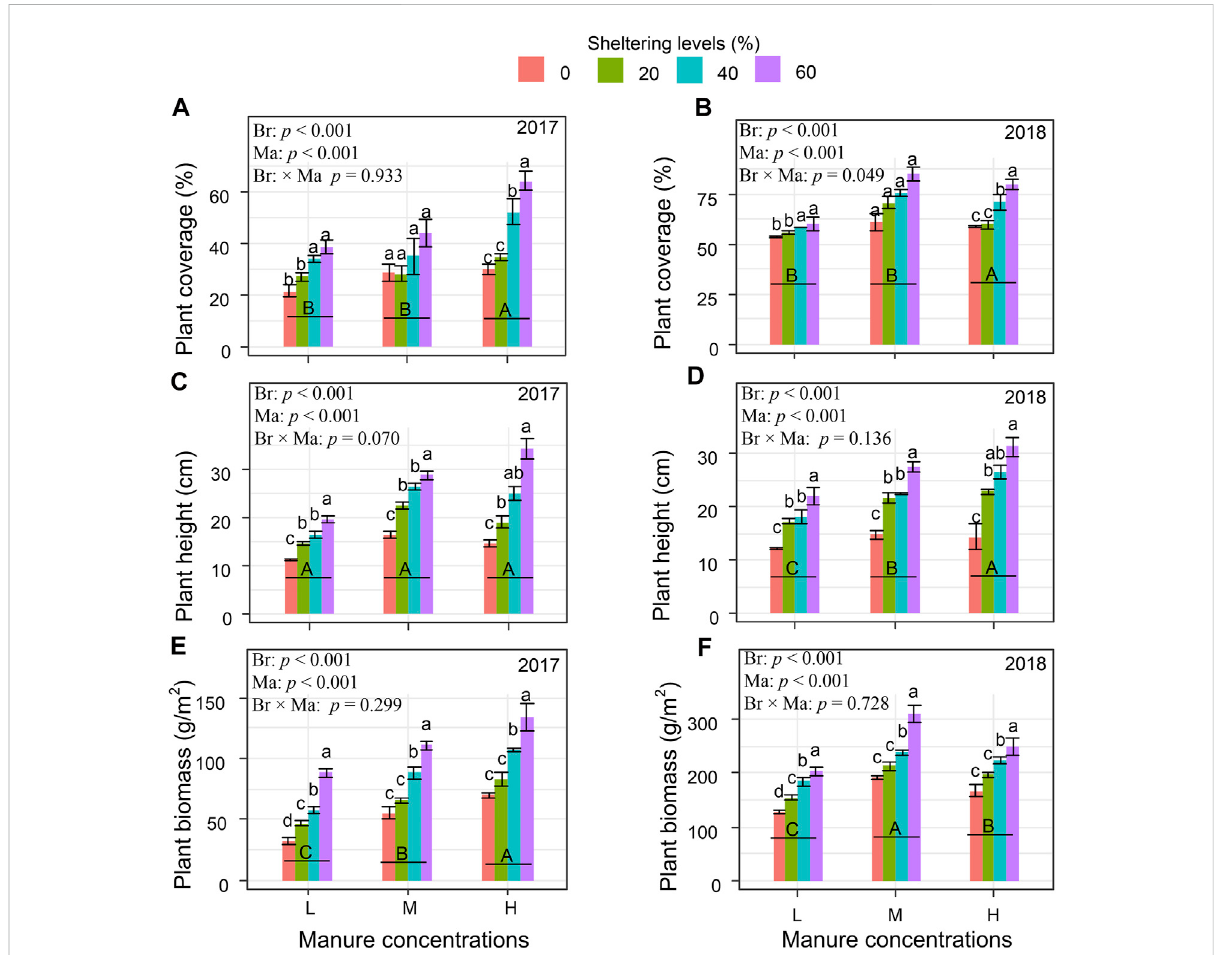
FIGURE 5 Plant coverage (A,B) , height (C,D) , and biomass (E,F) under different shrub branch sheltering levels and cumulative sheep manure concentrations in degraded grassland in 2017 and 2018. L, M, and H denote sheep manure with low, medium, and high concentration in grasslands. Different uppercase letters indicate signi fi cant differences among different concentrations of sheep manure ( p < 0.05), while lowercase letters indicatesigni fi cantdifferencesamongdifferentlevelsofshrubbranchshelter( p < 0.05).Different p